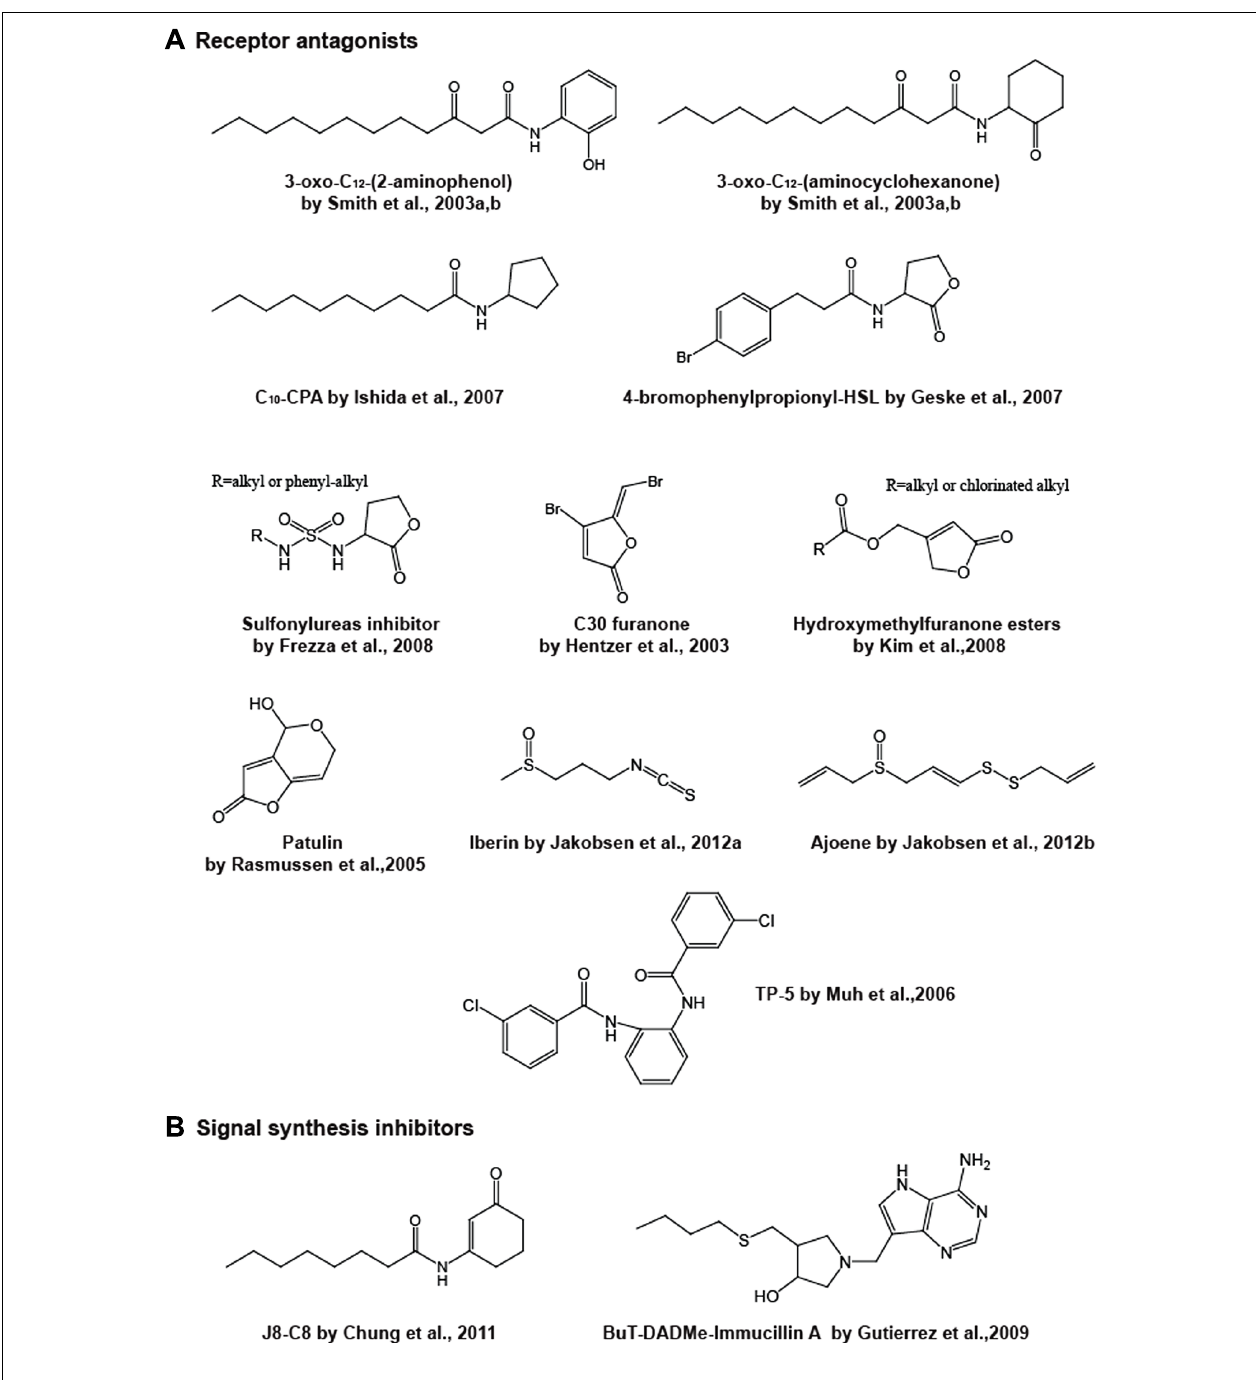
FIGURE 3 | Chemical structures of representative receptor antagonists (A) and signal synthesis inhibitors